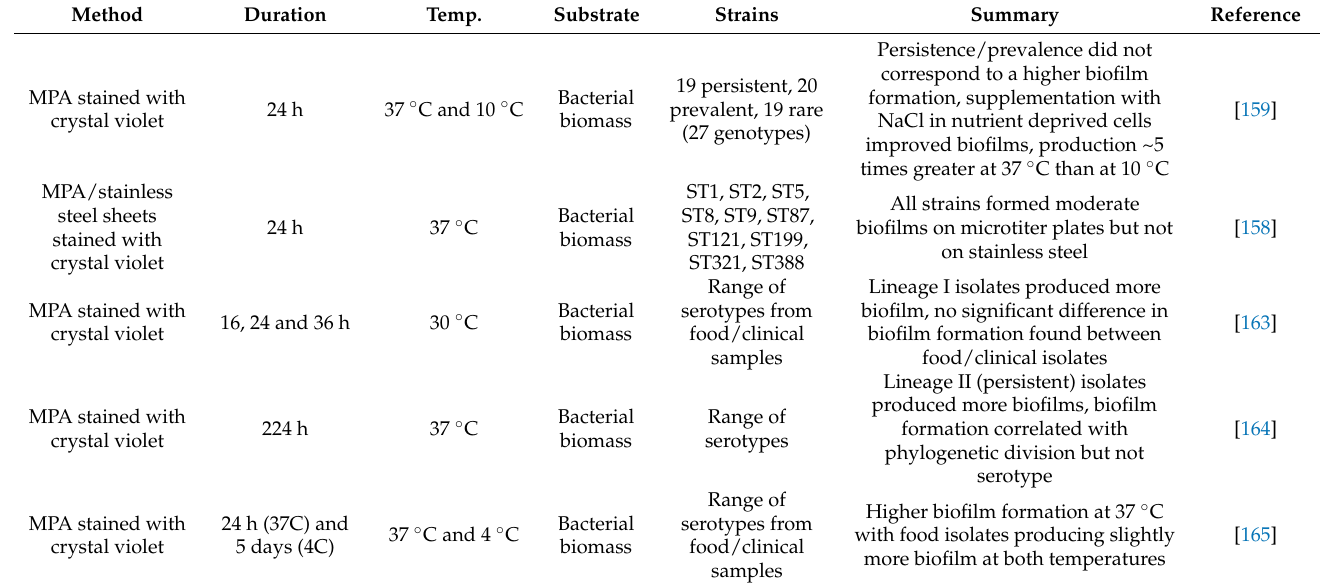
Table 4. Comparison of results obtained from crystal violet staining of biofilms in literature. Method Duration Temp. Substrate Strains Summary